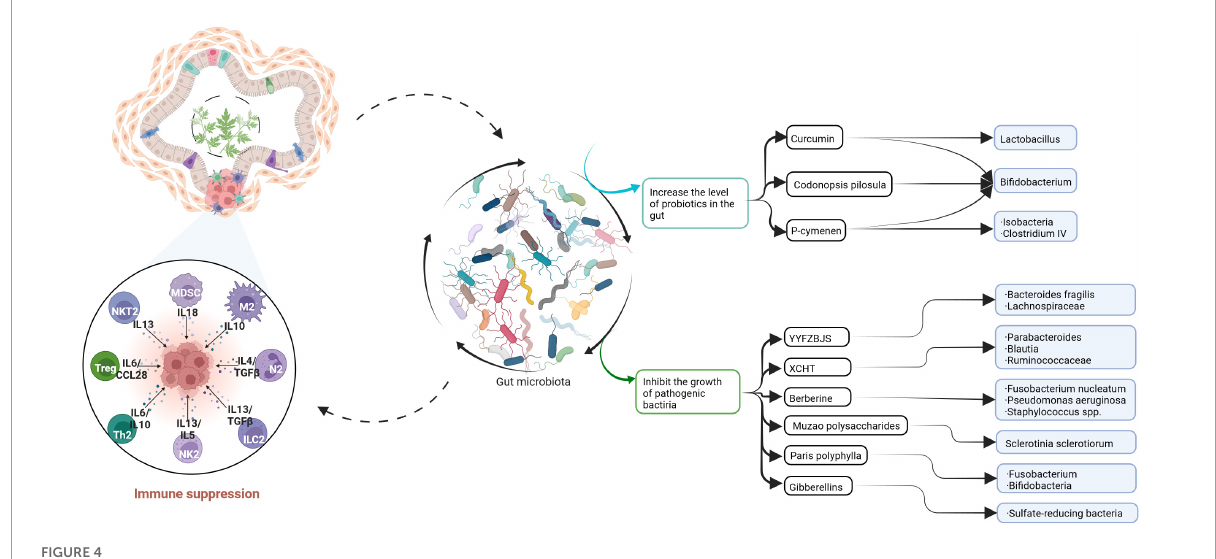
FIGURE4 This paper summarizes the relationship between traditional Chinese medicine and gut microbiota and CRC. Curcumin, Codonopsis pilosula , and P -cymenen increased the abundance of intestinal probiotics. Some Chinese herbal extracts or prescriptions can inhibit the growth of pathogenic bacteria. Traditional Chinese medicine increases the richness of gut microbiota, thereby enhancing the body’s immunity and playing an anti-CRC role.